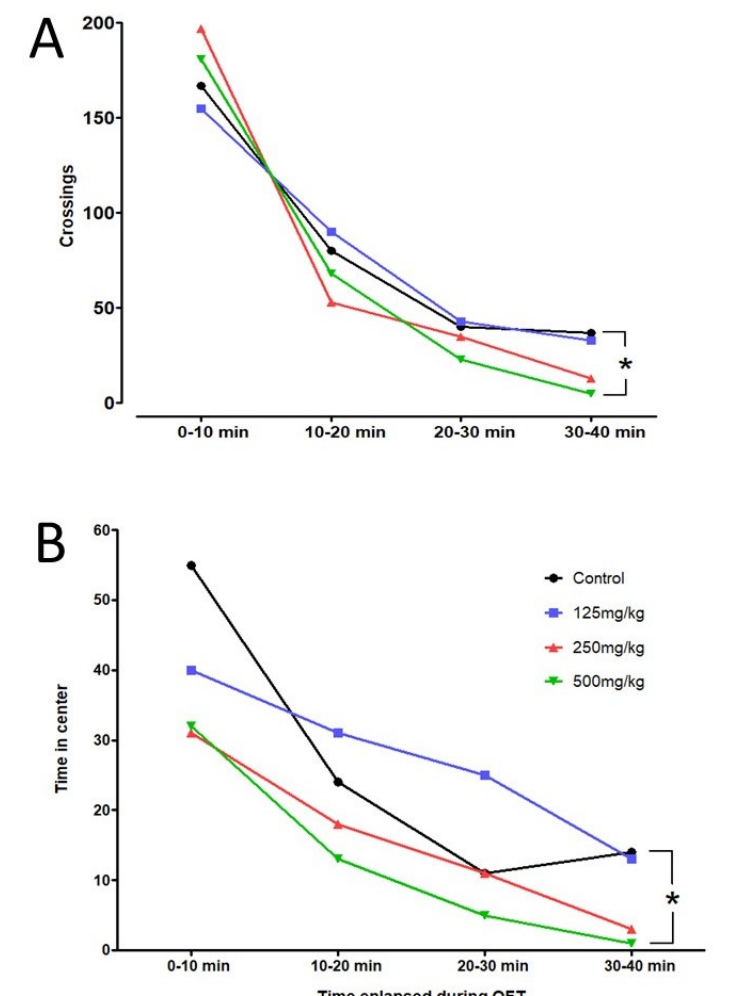
FIGURE 1 - The lines represent the number of line crossings (A) and time spent in the center of the apparatus (B) of 0 mg kg -1 (control; black line), 125 mg kg -1 (blue line), 250 mg kg -1 (red line), and 500 mg kg -1 (green line) of AYA intake over time in the OFT. Results with statistically different values ( p < 0.05) are marked with an asterisk (*) when compared to the control